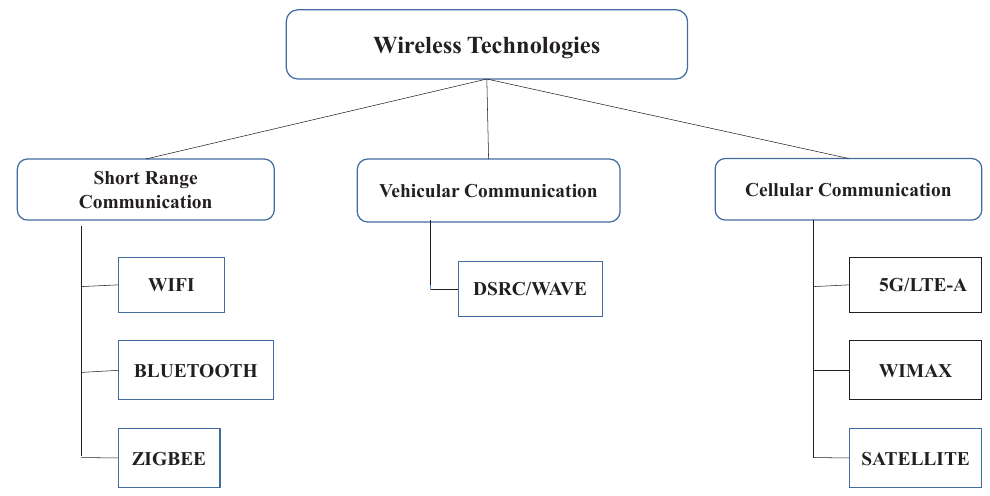
Figure 3. Communication